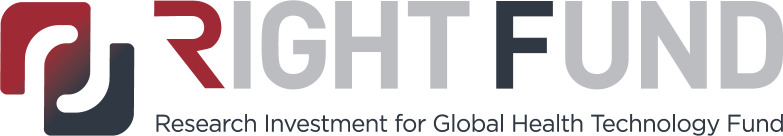
Logo of the new Korean RIGHT Fund.From http://rightfund.org. RIGHT, Research Investment for Global Health Technology.